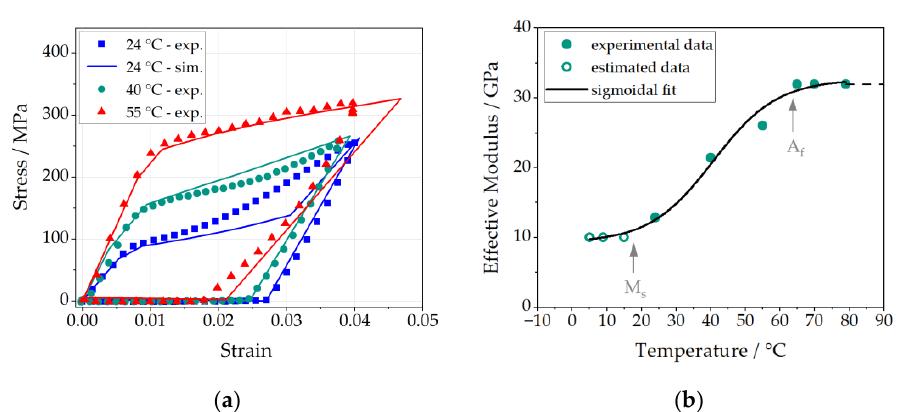
Figure 2. ( a ) Experimental and simulated stress – strain characteristics at different temperatures as indicated; ( b ) temperature-dependent effective modulus used in the present model to describe the mechanical response in the temperature regime of co-existing R- and A-phase.